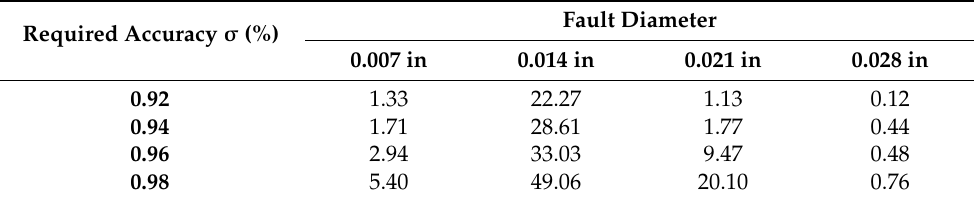
Table 4. The standard deviation of the sampling number in group B.